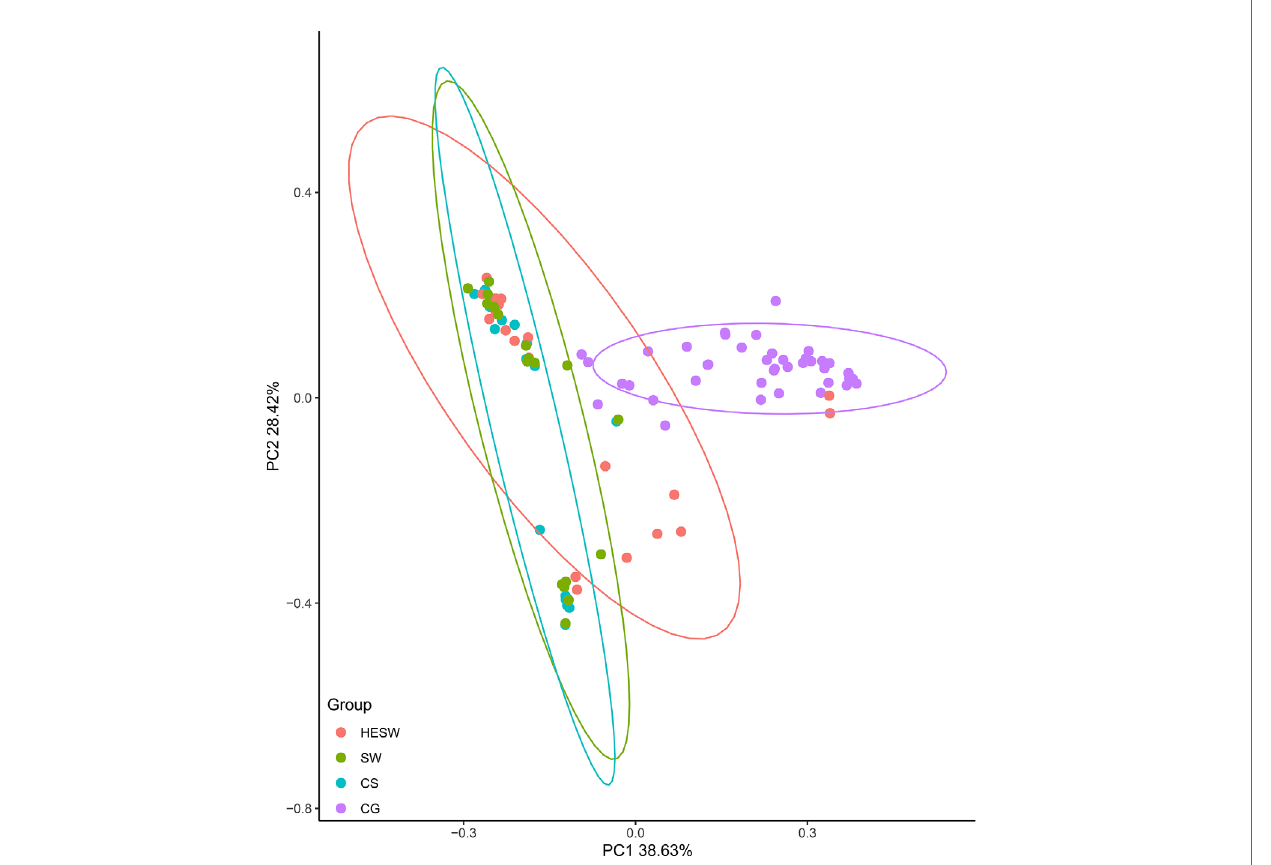
FIGURE 3 | On the dimensionality of beta diversities, PCoA plots suggest the sort and richness of ocular bacterial microbiota from the healthy eyes of BK patients had signi fi cant difference from the eyes of healthy people. Two-dimensional PCoA plots with con fi dence ellipse (Weighted Unifrac algorithm) show the beta diversities of each sample. The abscissa (PC1) and the ordinate (PC2) are the two principal co-ordinates which have the largest interpretation of the difference between samples. The percentage on abscissa (or ordinate) represents the explanatory degree to the difference among samples. The CG group had signi fi cant difference from the HESW group (HESW, conjunctival swabs from the healthy eyes of BK patients; SW, conjunctival swabs from the diseased eyes of BK patients; CS, corneal scrapings from the diseased eyes of BK patients; CG, conjunctival swabs from the healthy volunteers; BK, bacterial